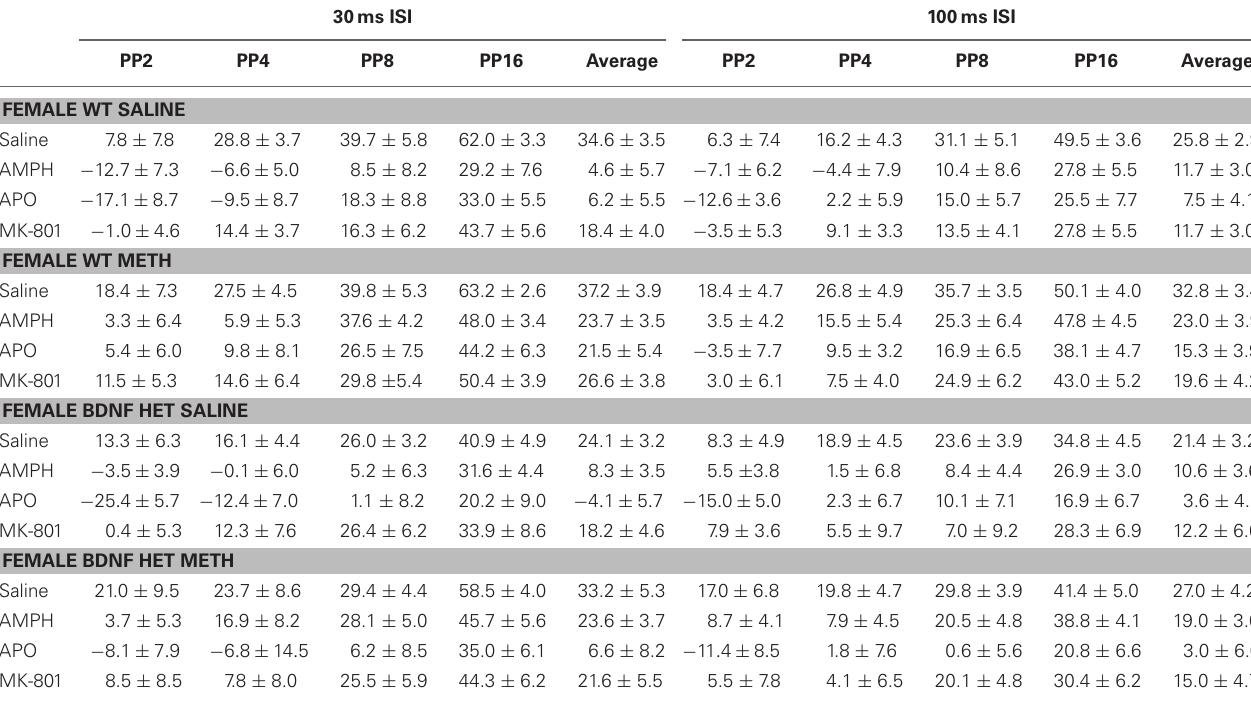
Table 2 | Mean PPI ± SEM at each PP intensity during challenge sessions with saline, AMPH, APO, or MK-801 treatment in female WT and BDNF HET mice chronically pre-treated with saline or